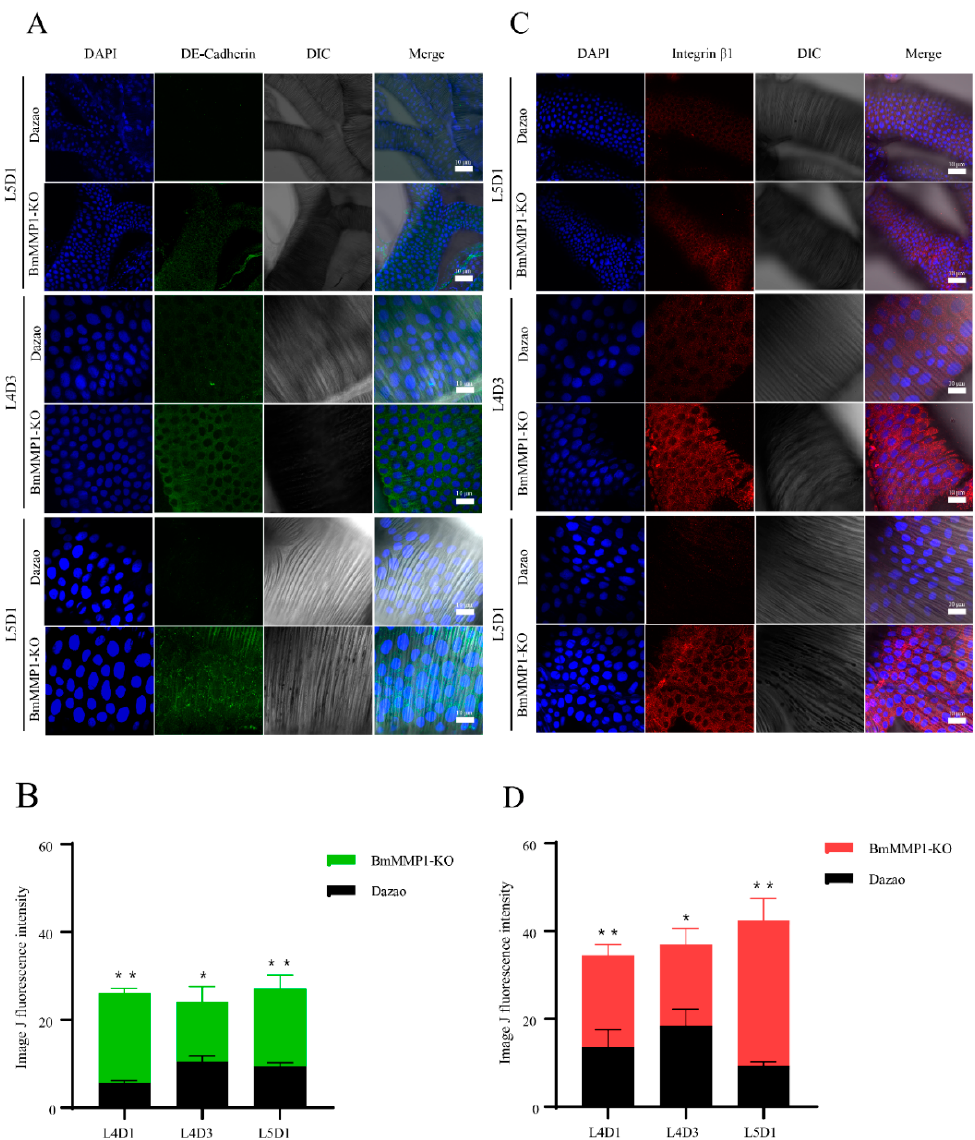
Figure 5. DE-cadherin and Integrin β 1 accumulated in the trachea of transgenic BmMMP1-KO silkworm. ( A ) Immuno- histochemistry assay for DE-cadherin of trachea in L4D1, L4D3, and L5D1. DAPI (Blue) stained cell nucleus and green fluorescence represents DE-cadherin. ( B ) Statistics of DE-cadherin fluorescence expression by ImageJ ( C ) Immunohisto- chemistry assay for Integrin β 1 of trachea in L4D1, L4D3, and L5D1. DAPI (Blue) stained cell nucleus and red fluorescence represents Integrin β 1. ( D ) Statistics of Integrin β 1 fluorescence expression by ImageJ. (*, 0.01 ≤ p < 0.05; * *, p <